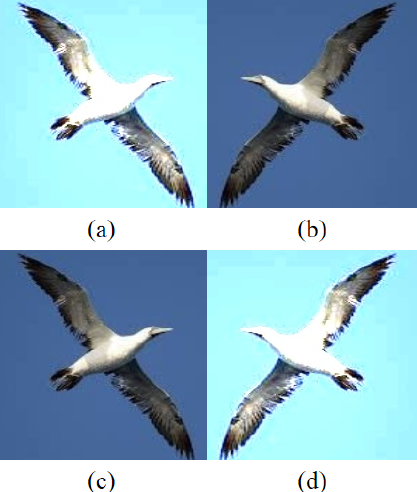
Figure 2. Data Preprocessing. ( a ) Enhancing brightness after flipping the original image. ( b ) Original image. ( c ) Flipped image. ( d ) Image with enhanced